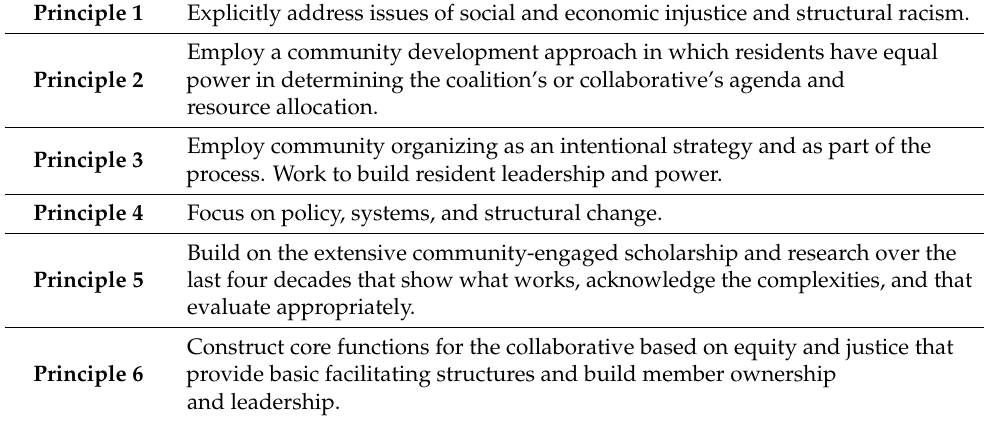
Table 1. Principles for Collaborating for Equity and Justice